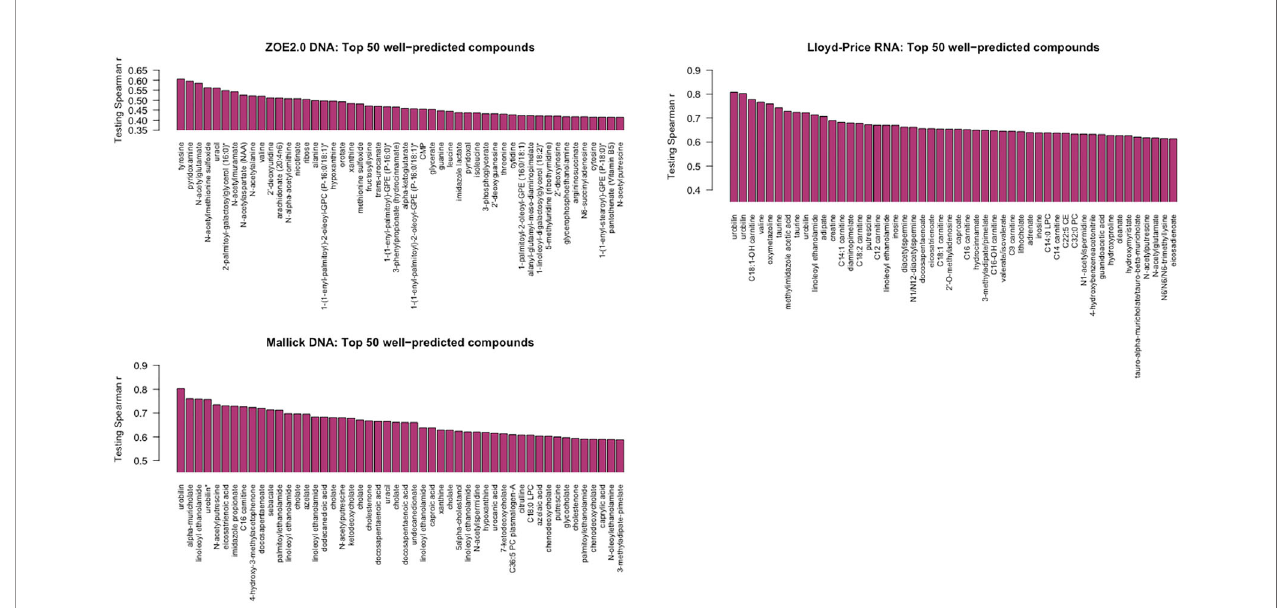
FIGURE 7 | The best predicted 50 metabolite compounds ( x -axis) in the three studies by ENVIM in the testing set. For Lloyd-Price and ZOE 2.0, we choose the gene family data types that have the best ENVIM prediction power to show their top predicted metabolites, based on Table 2